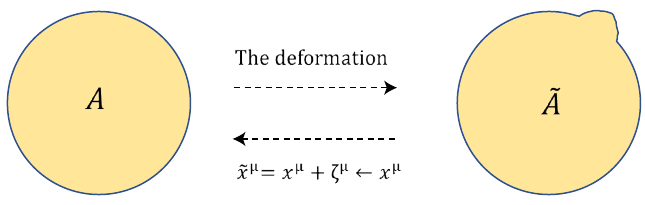
Figure 2 . Relating shape deformation to metric deformation via a corresponding